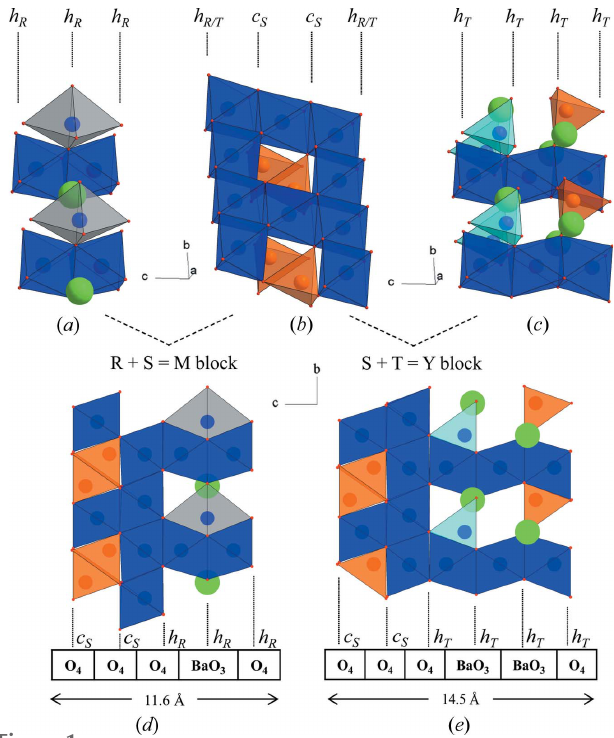
Figure 1 Three-dimensional views of ( a ) the R, ( b ) the S and ( c ) the T sub-blocks and projections of ( d ) the M and ( e ) the Y blocks. Fe 3+ octahedra are represented in dark blue, Fe 3+ bipyramids in grey, Fe 3+ tetrahedra in light blue and mixed Fe 3+ /Zn 2+ tetrahedra in orange. The h and c notations indicate hexagonal and cubic packing of the oxygen layers, respectively. Subscript letters correspond to the sub-block types these oxygen layers belong to. The anion-layer stacking and c dimension of the M and Y unit blocks are also